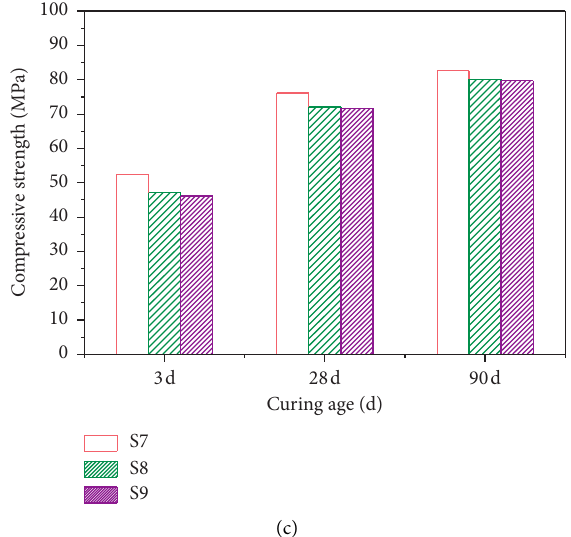
Figure 3: Compressive strength of HPC with different mineral admixtures. (a) Fly ash; (b) CFBC ash; (c) CFBC